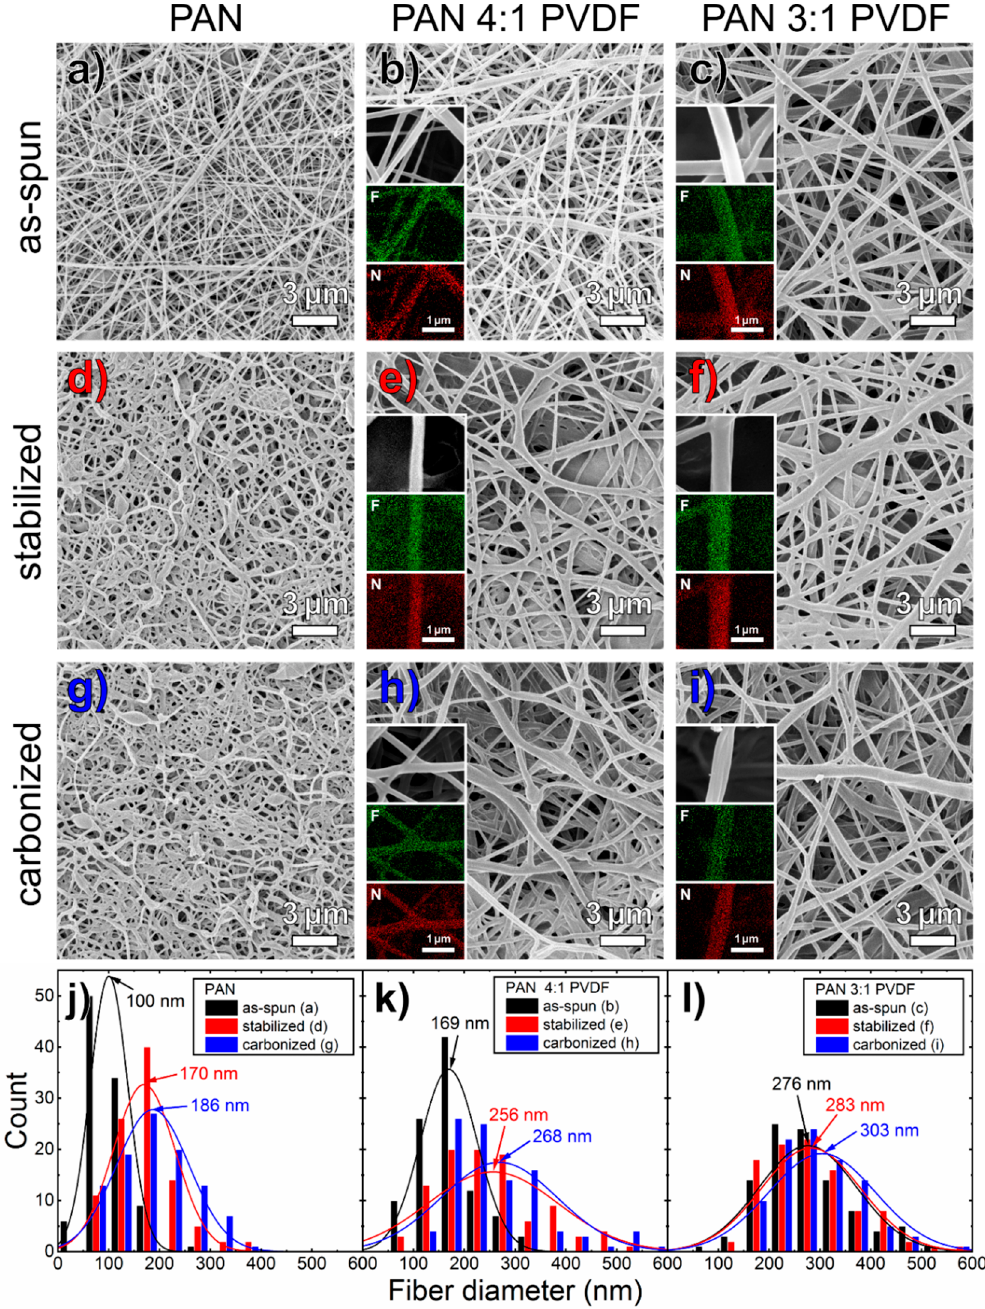
Figure 2. ( a – i ) HIM images of all examined nonwovens with a field of view of 20 µ m × 20 µ m in combination with EDX maps on individual blend nanofibers, taken at the same samples and given as inserts for fluorine (green) and nitrogen (red) signal images, respectively; and ( j – l ) corresponding fiber diameter histograms with normal